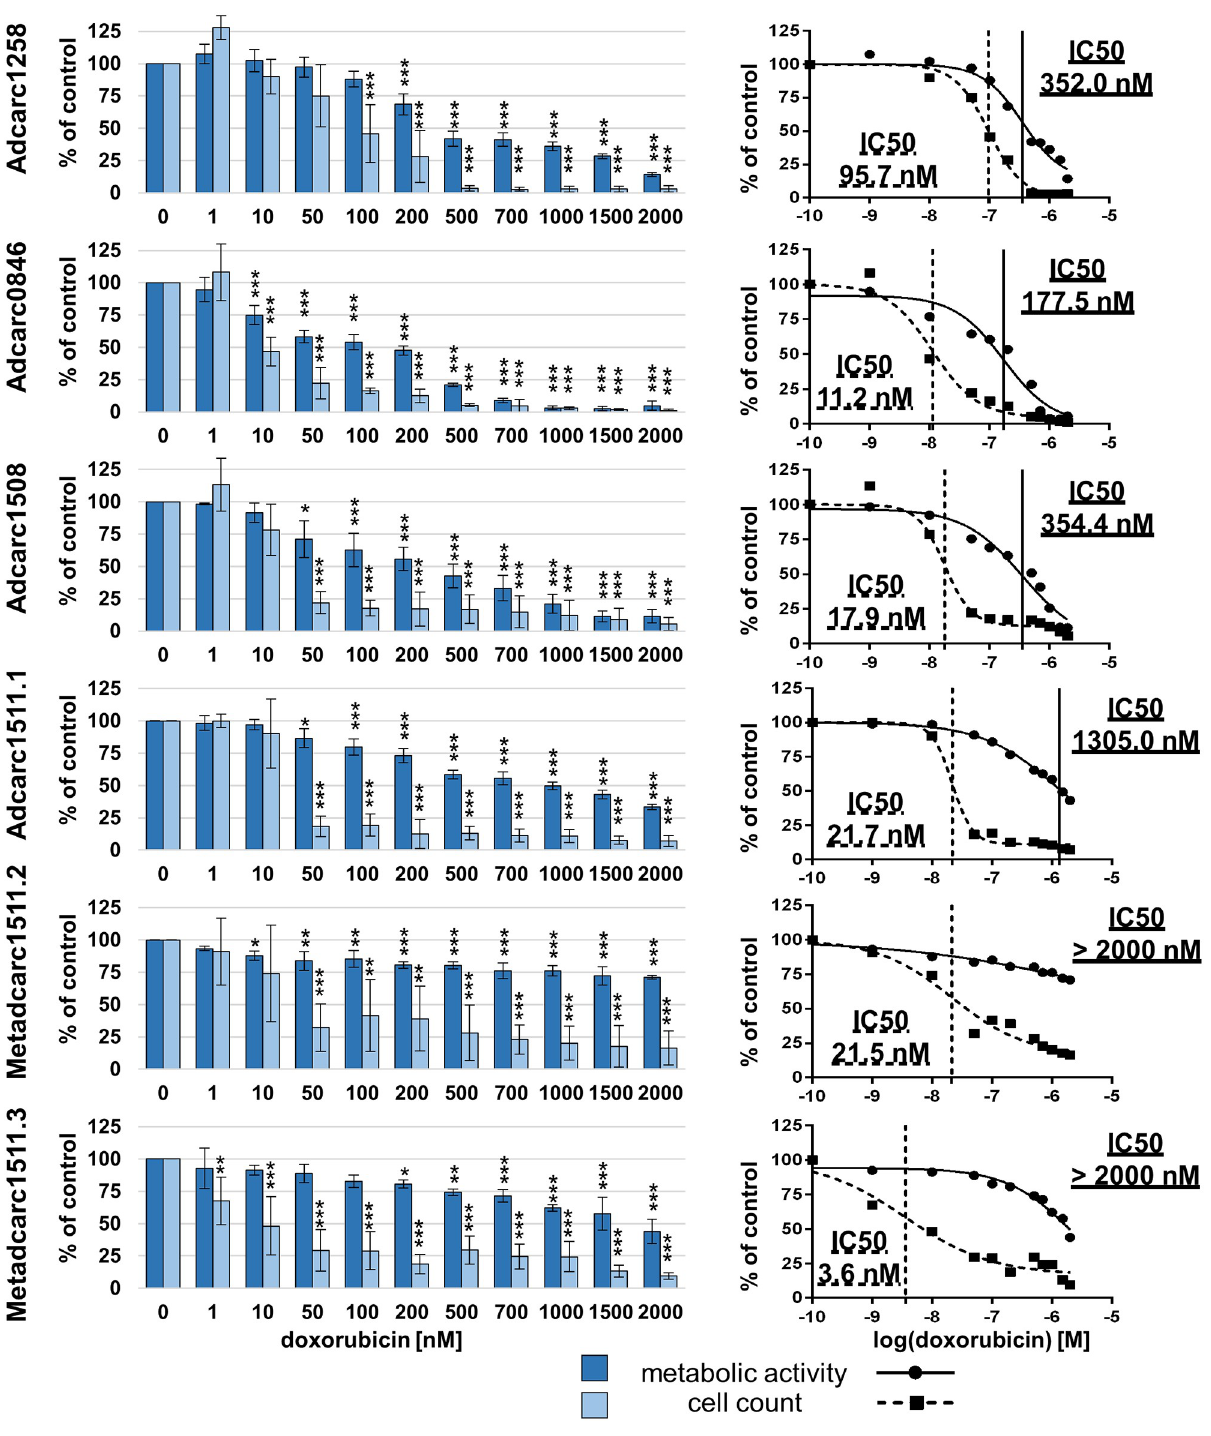
Fig 3. Metabolic activities and cell counts of PAC cell lines after 72 h incubation with doxorubicin. Means and standard deviation are displayed, n = 3 for metabolic activity, n = 4 for cell count, significances are referred to controls. � p < 0.05, p �� < 0.01 and p ��� < 0.01.